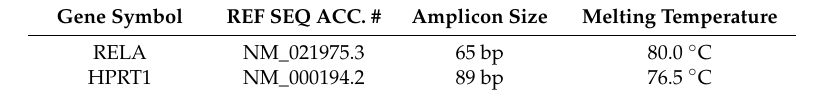
Table 6. RT-qPCR primer pairs * as described in the RT2 qPCR Primer Assay (SABiosciences). Gene